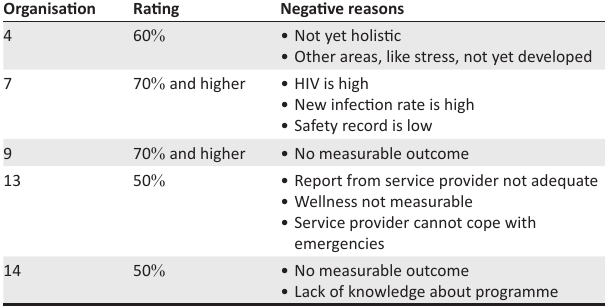
TABLE 6: Reasons for rating employee wellness programmes as less successful. Organisation